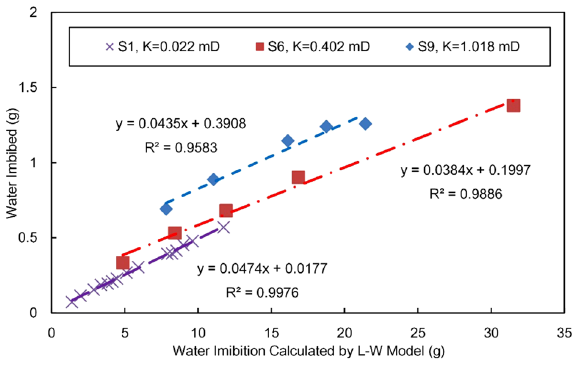
Figure 9. Experimental water imbibition versus the calculated value of L-W model.